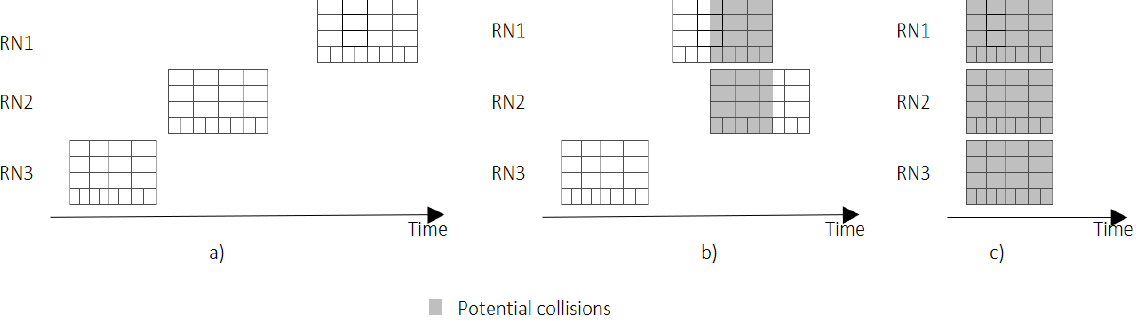
Figure 13. The asynchronous behavior between RNs: ( a ) ideal case, ( b ) typical case, ( c ) worst case.